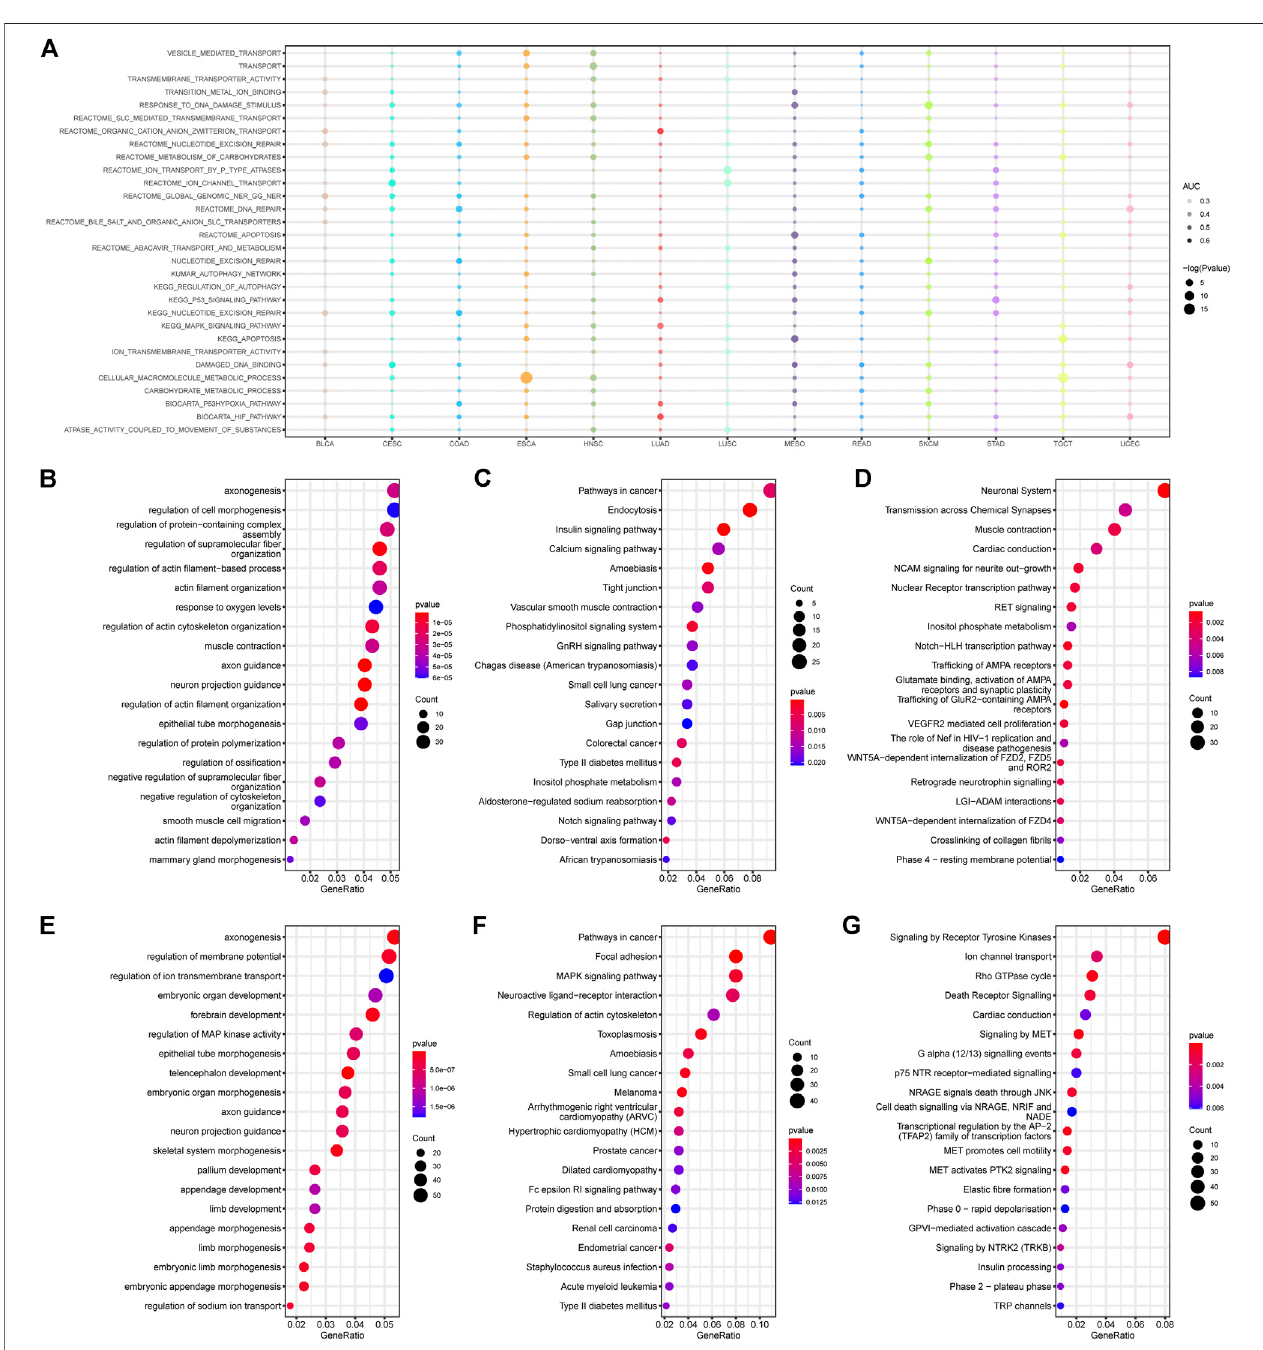
FIGURE2| Enrichmentresultsofthemethylationpro fi lescorrelatedwithplatinumresistance. (A) EmpiricalBayesgenesetenrichmentanalysis(ebGSEA)resultsof 30 platinum response-related gene sets across 13 cancer types. (B – D) Gene Ontology (GO), the Kyoto Encyclopedia of Genes and Genomes (KEGG), and Reactome enrichment results of the hypermethylated DMPs in PR patients. (E – G) GO, KEGG, and Reactome results of the hypomethylated DMPs in PR patients.